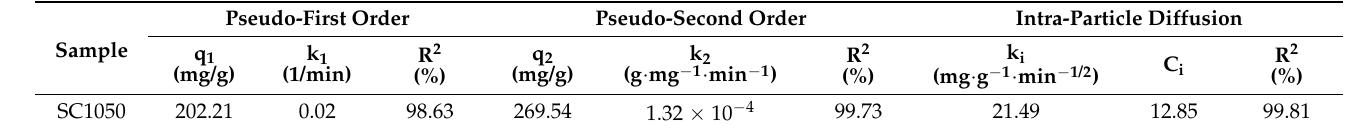
Figure 10. ( a ) The effect of adsorption time for the adsorption of MB onto SC1050 and plots for ( b ) pseudo-first-order, ( c ) pseudo-second-order and ( d ) intra-particle diffusion models. Table 5. Kinetic parameters for the adsorption of MB onto SC1050 obtained by plotting.